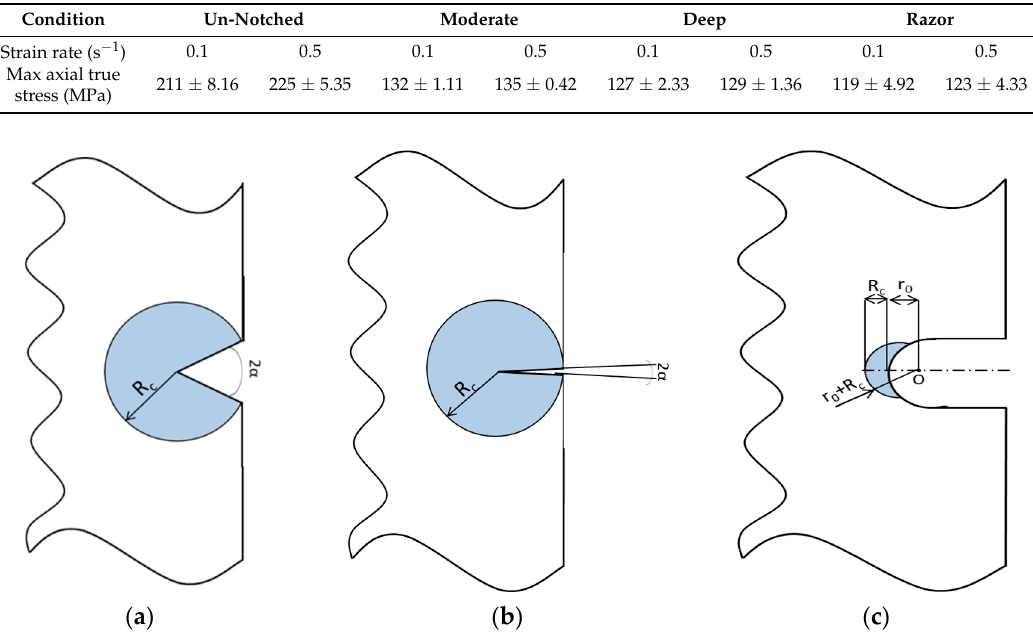
Figure 2. Control volume for sharp V-notch ( a ), crack case ( b ) and U notch ( c ) under mode I loading. Chen et al. [11] assessed the fracture behavior of PEEK 450G (Röchling Group, Mannheim, Germany)